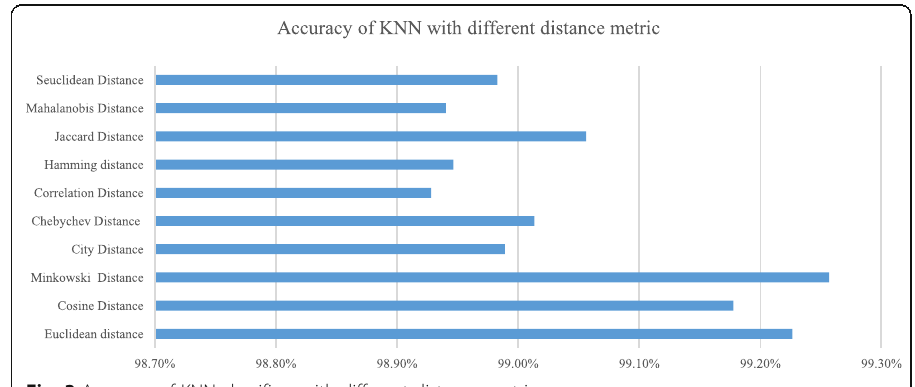
Fig. 3 Accuracy of KNN classifiers with different distance